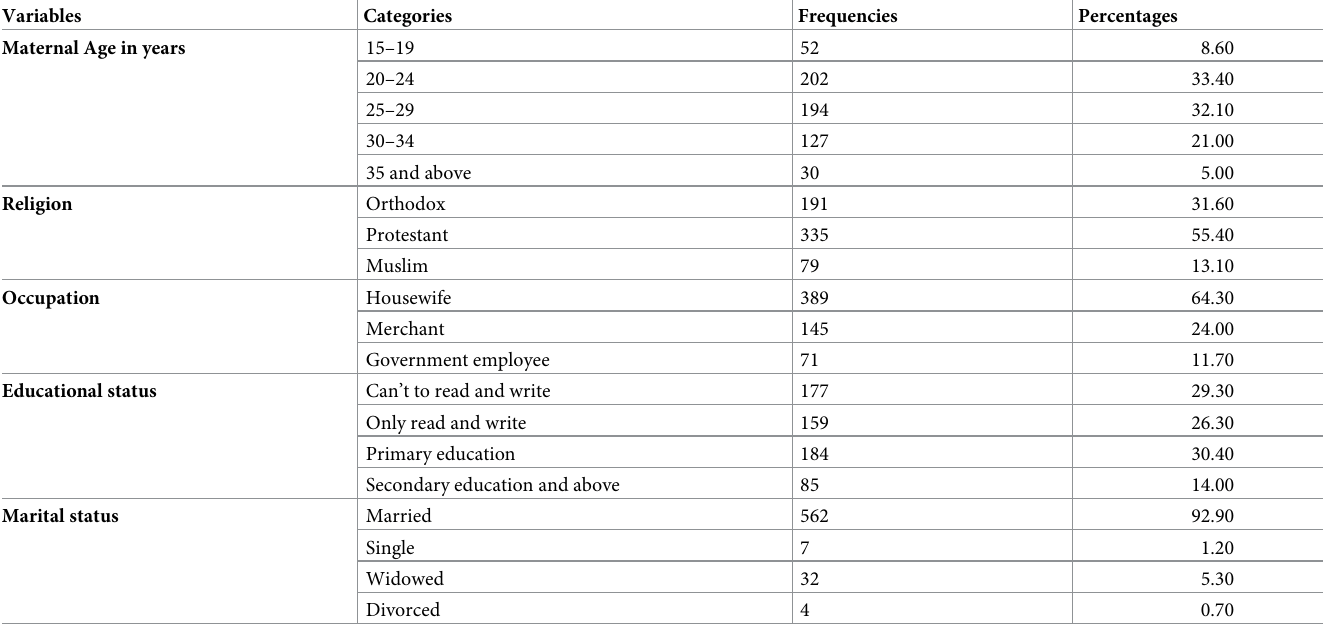
Table 1. Socio-demographic characteristics of pregnant